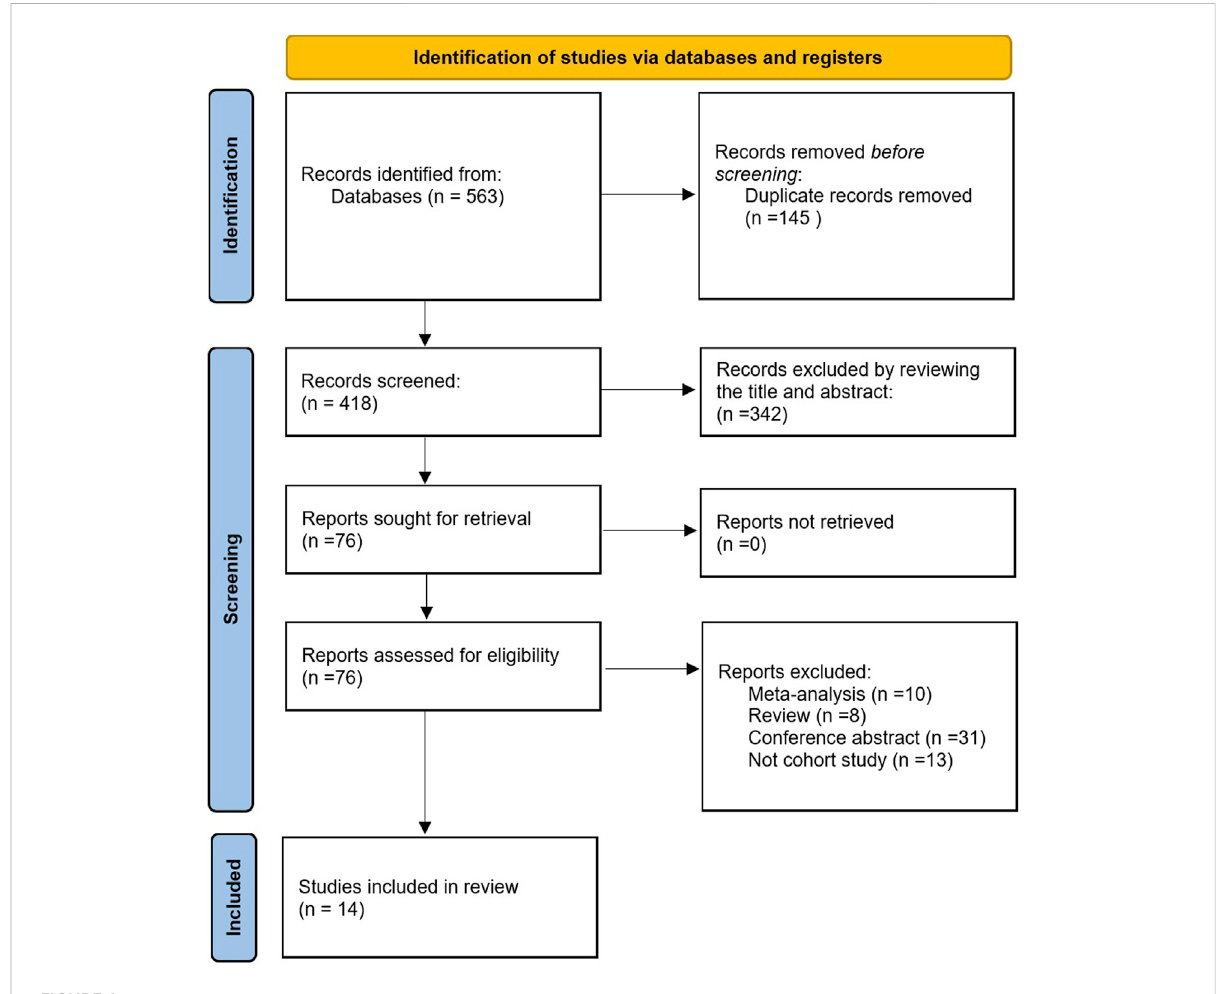
Literature screening fl